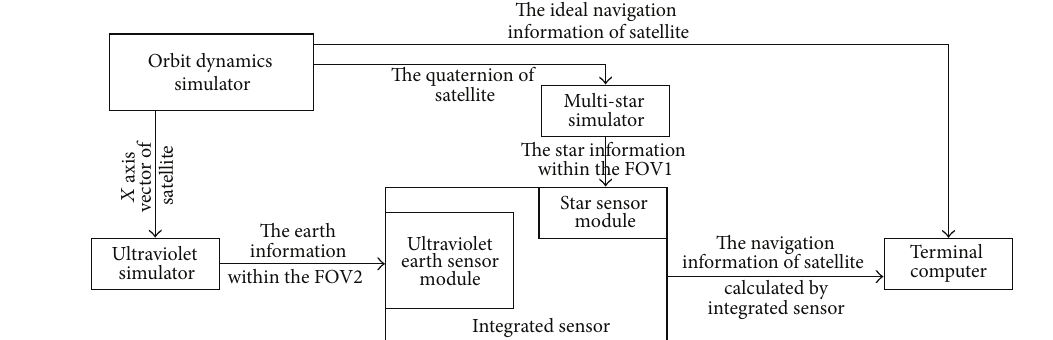
Figure 7: The experiment method of integrated sensor.